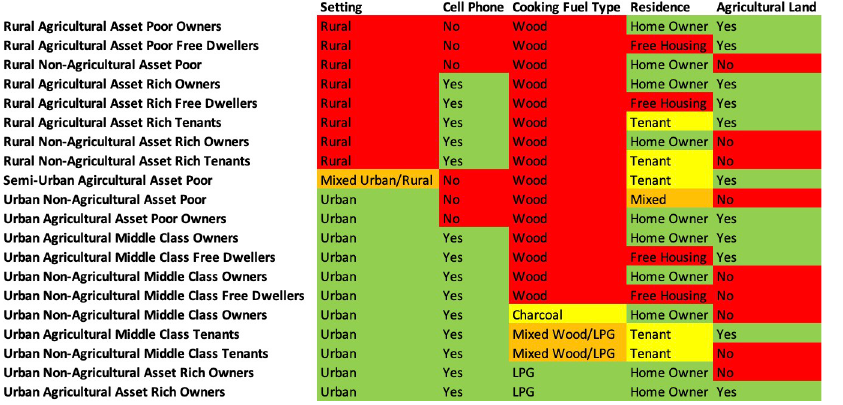
Fig 1. Most common defining assets of twenty Cameroonian EconomicClusters and proposed cluster interpretations. Caption: For more details regarding the development of this model, please see Eyler et al. [14].